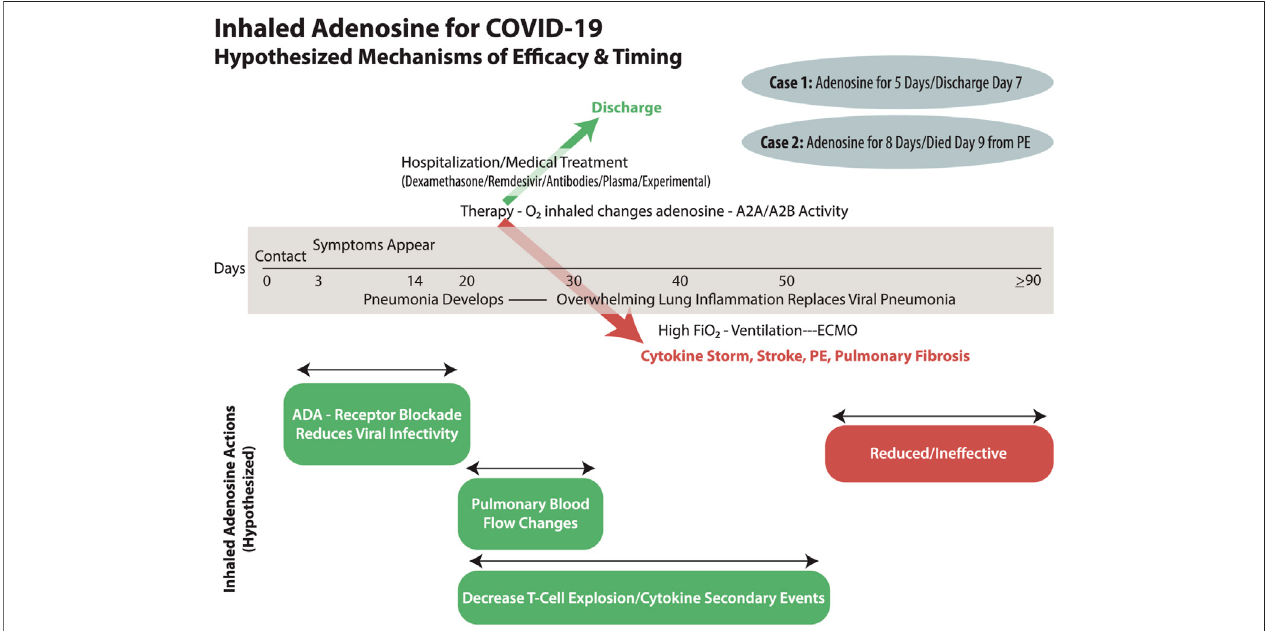
FIGURE 1 | COVID-19 has an individualized and varied timeline from exposure through nasopharyngeal infection, pulmonary spread, pneumonia, and then secondary ARDS. The involvement of oxygen therapy needs to be explored as both a therapeutic and causative player in ARDS as well as the explosive in fl ammatory cytokine storm of events. The timely use of inhaled adenosine may have ef fi cacy in treatment of COVID-19 infection and secondary complications depending upon the multiple mechanisms by which it could act. Our two patients had a rapid response that almost certainly must have been due to pulmonary blood fl ow issues, but they recovered from severe COVID-19 ARDS with consecutive days of inhaled therapy. Eventually, and late in the ARDS lung fi brosis continuum, it must be that inhaled adenosine will have reduced effectiveness.